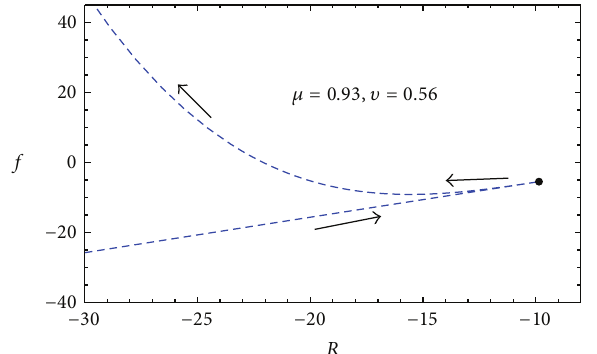
Figure 13: Future evolution of 𝑓(𝑅) for (𝜇,𝜐) = (0.93, 0.56) with −1 ≲ 𝑧 ⩽ 2 . The dot denotes the present day and is the point of reversion for DE dominated model.